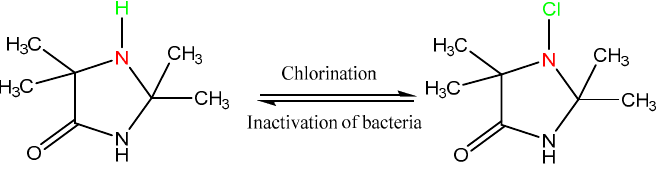
Scheme 2. Schematic synthesis routes of 2-acrylamido-2-methyl-1-(5-methylhydantoinyl)propane/